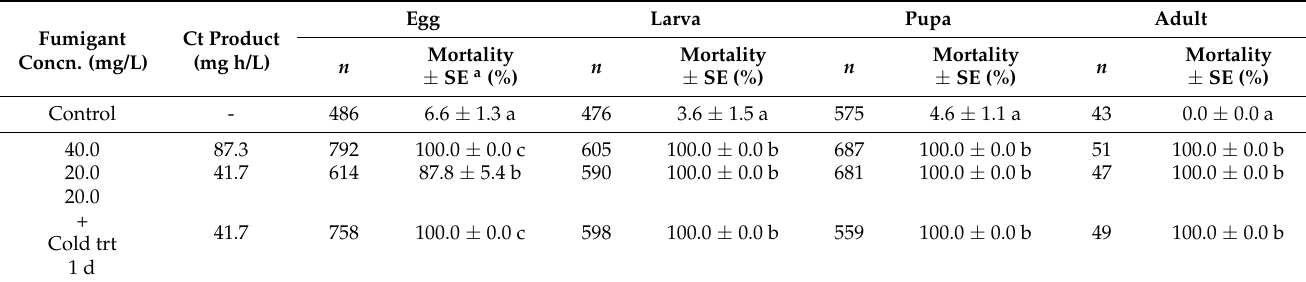
Table 5. Mortality of D. suzukii exposed to methyl bromide for 3 h at 18 ◦ C in 12 L desiccator. Fumigant Concn.